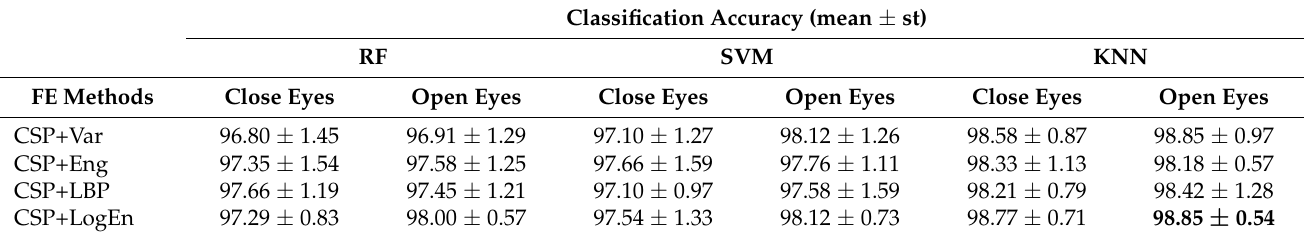
Table 14. Classification results of on–PD vs. HC (UNM